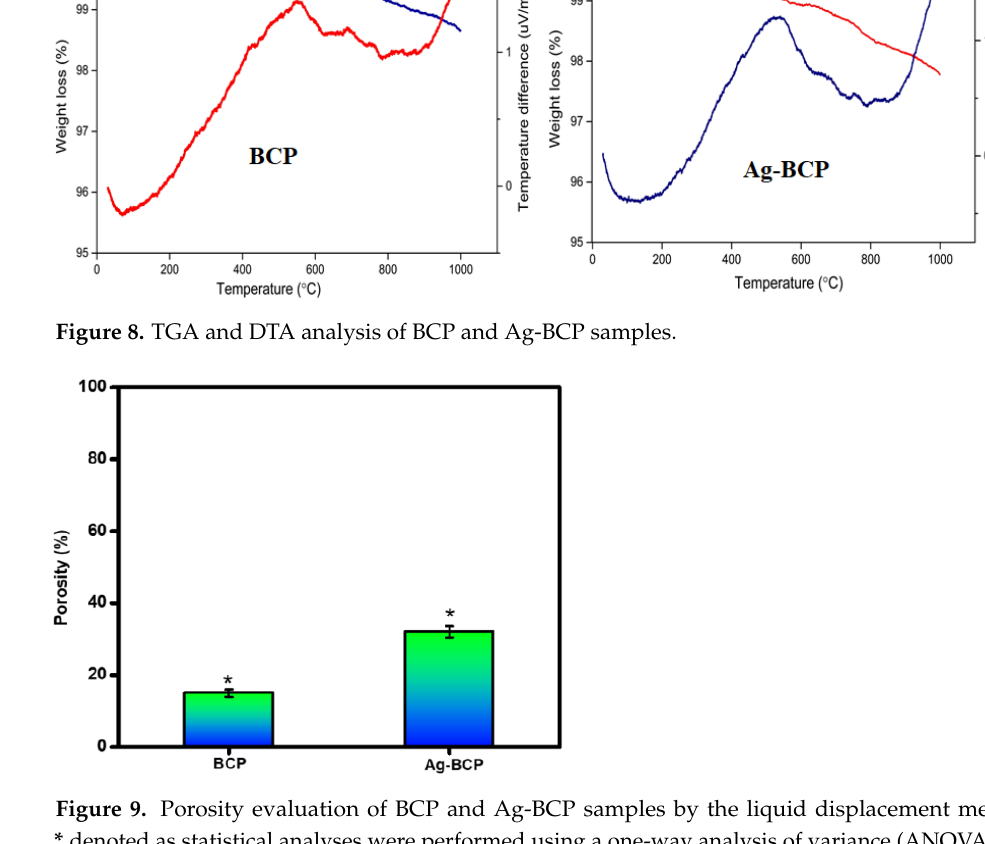
Figure 9. Porosity evaluation of BCP and Ag-BCP samples by the liquid displacement method. * denoted as statistical analyses were performed using a one-way analysis of variance (ANOVA) and the data presented are the mean ± standard